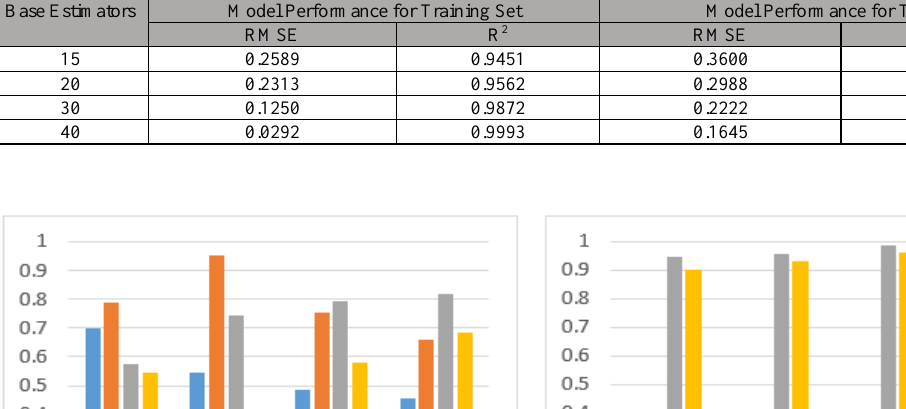
Table 3. Model performance comparison for regularised Gaussian Basis Regression Model Base Estimators Model Performance for Training Set